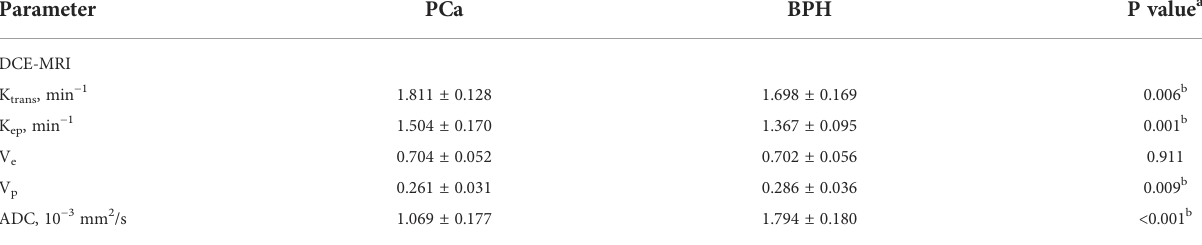
TABLE 2 DCE-MRI parameters and ADC for PCa and BPH